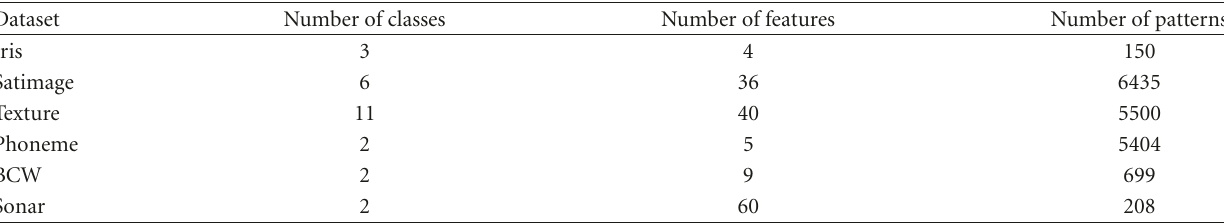
Figure 2: Application of the proposed algorithm for partitioning of the input space in Iris CR dataset, (a) without and (b) with LDA in the pre-processing phase. Table 1: Main features of datasets used in our experiments.